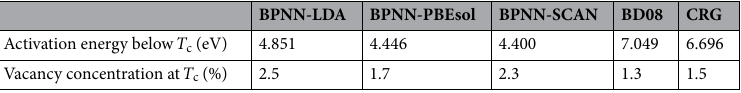
Table 4. Activation energy of diffusion below T c and vacancy concentration at T c .